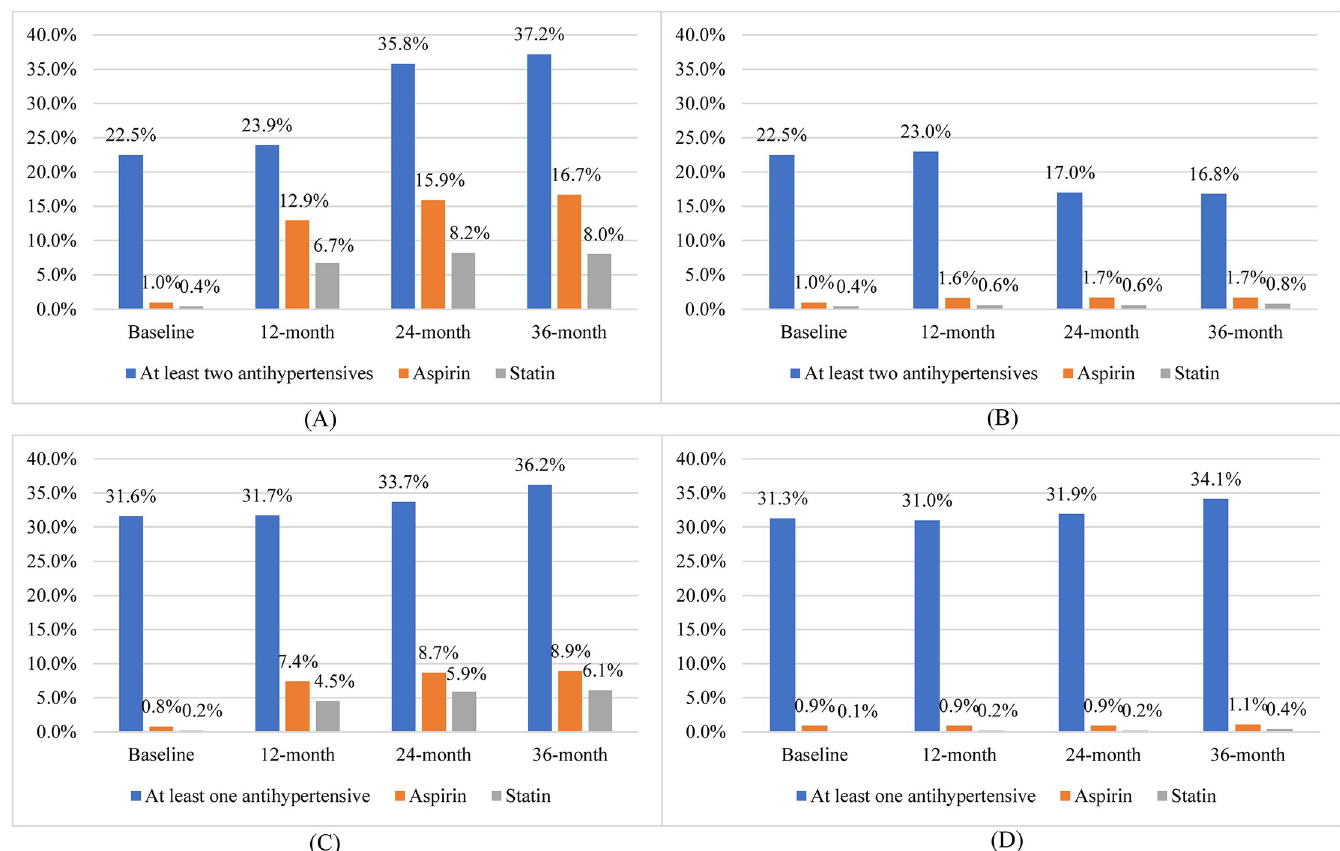
Fig 3. Self-reported adherence to medicines. (A and B) Self-reported adherence to medicines among patients with hypertension or hypertension and type 2 diabetes in the (A) intervention and (B) control groups. (C and D) Self-reported adherence to medicines among patients with type 2 diabetes only in the (C) intervention and (D) control